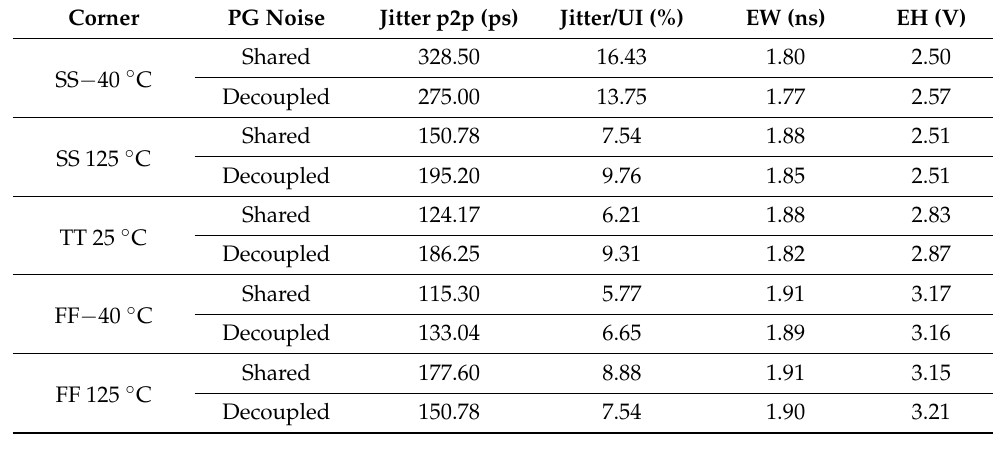
Table 5. Eye Diagram Metrics: Shared vs. Decoupled Cases.